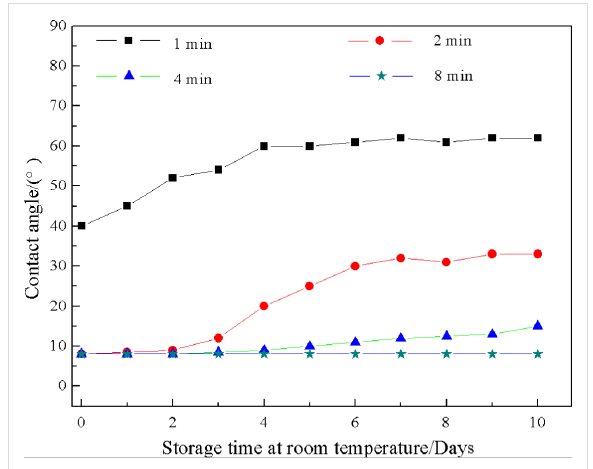
Figure 10: Changes in contact angle of the coating as a function of storage time for four charging times at 2000 V and 150 °C.